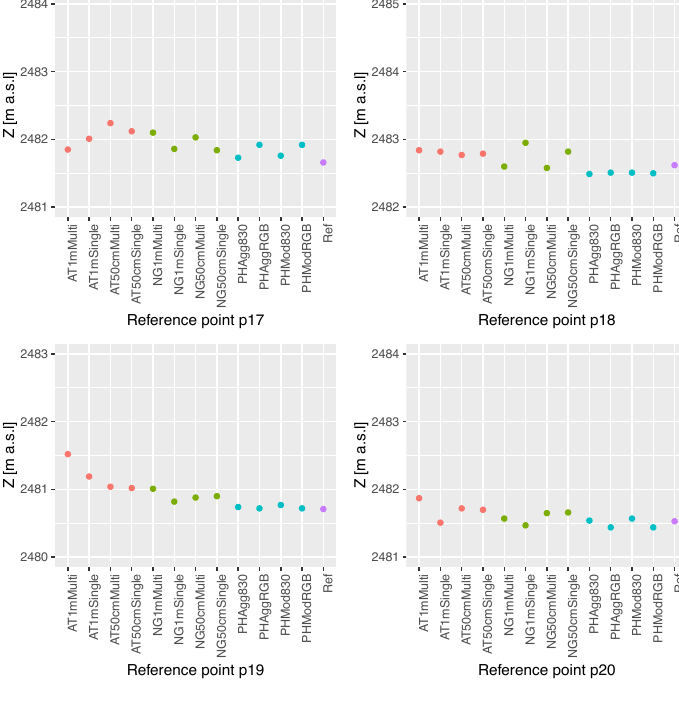
Figure 7. Reference point 17-20 (reference height at the far